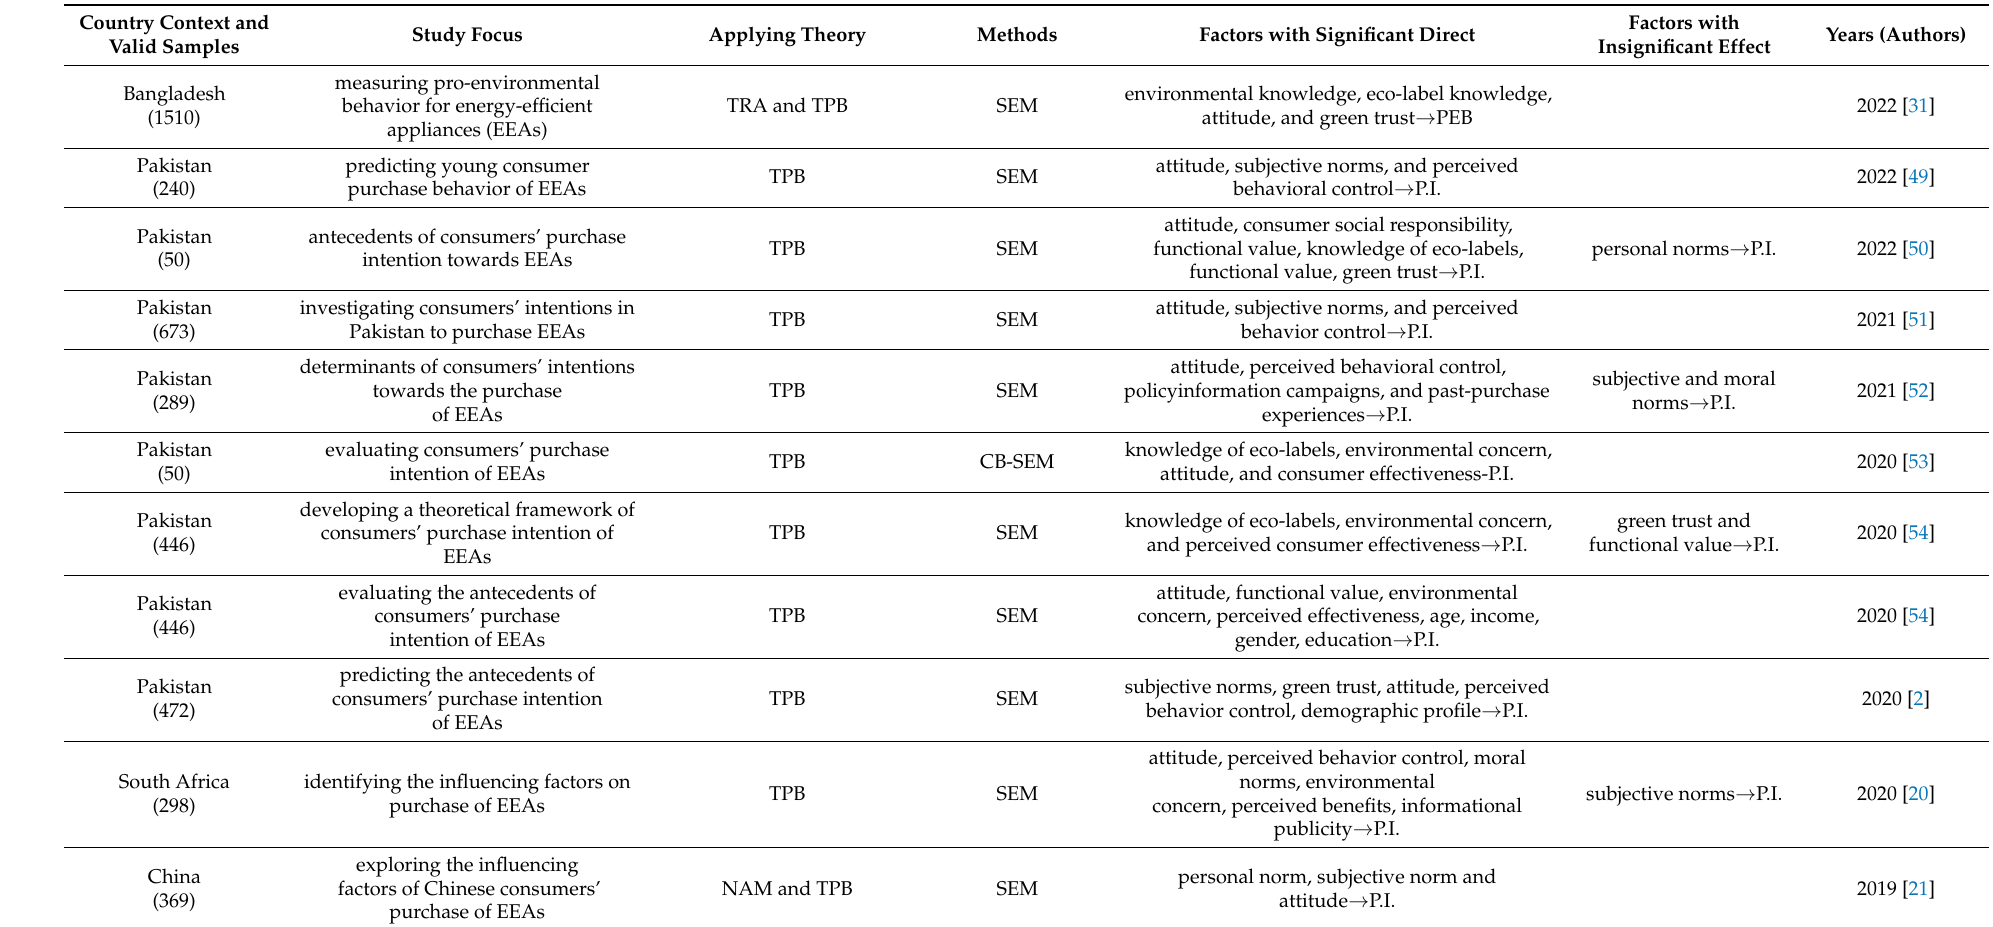
Table 1. Previous ten years of research on consumer purchase behavior of energy-efficient appliances